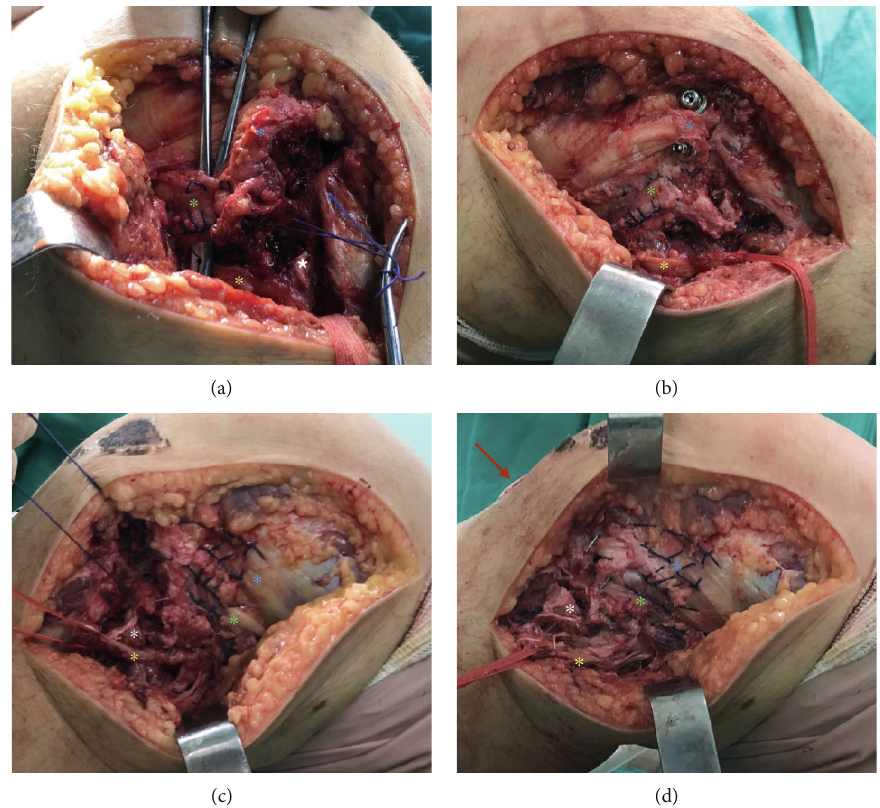
Figure 2: (a) Lateral approach to the right knee showing the tendon of the long head of the biceps repaired by Krackow suture, identi fi ed and isolated fi bular nerve, fi bular head with avulsed fragment and lateral margin of the tibia with the iliotibial band completely inserted to the full. (b) Right knee after Segond fragment fi xation and transosseous PLC repair. (c) Lateral approach to the left knee showing extensive injury on the lateral edge of the tibia near the iliotibial band and comminuted avulsion fracture of the fi bular head next to the tendon of the long head of the intact biceps. (d) Left knee after Segond fracture fi xation with pull out associated with Kirschner wires and transosseous PLC repair ( green asterisk =tendon of the long head of the biceps; yellow asterisk = fi bular nerve; white asterisk =head of the fi bula with avulsed fragment; blue asterisk =lateral edge of the tibia with iliotibial band completely inserted in full; red arrow =mini access for positioning of pull-out